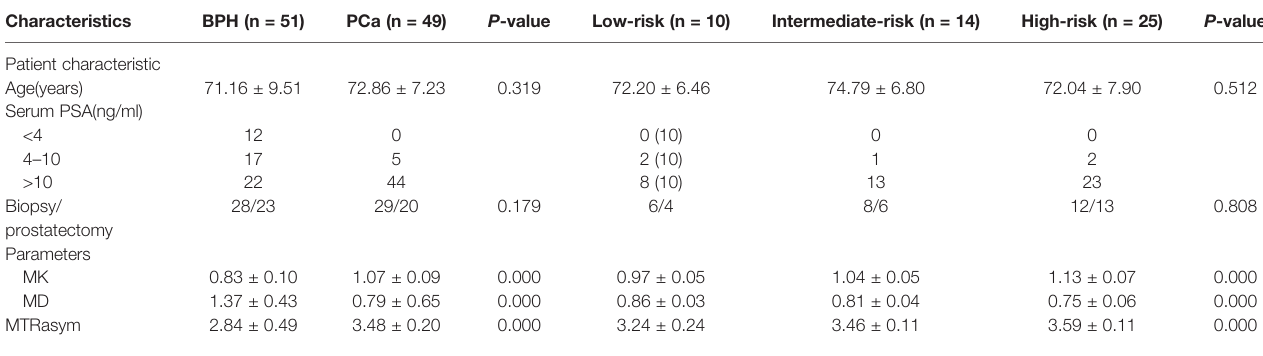
TABLE 2 | Characteristics of patients and